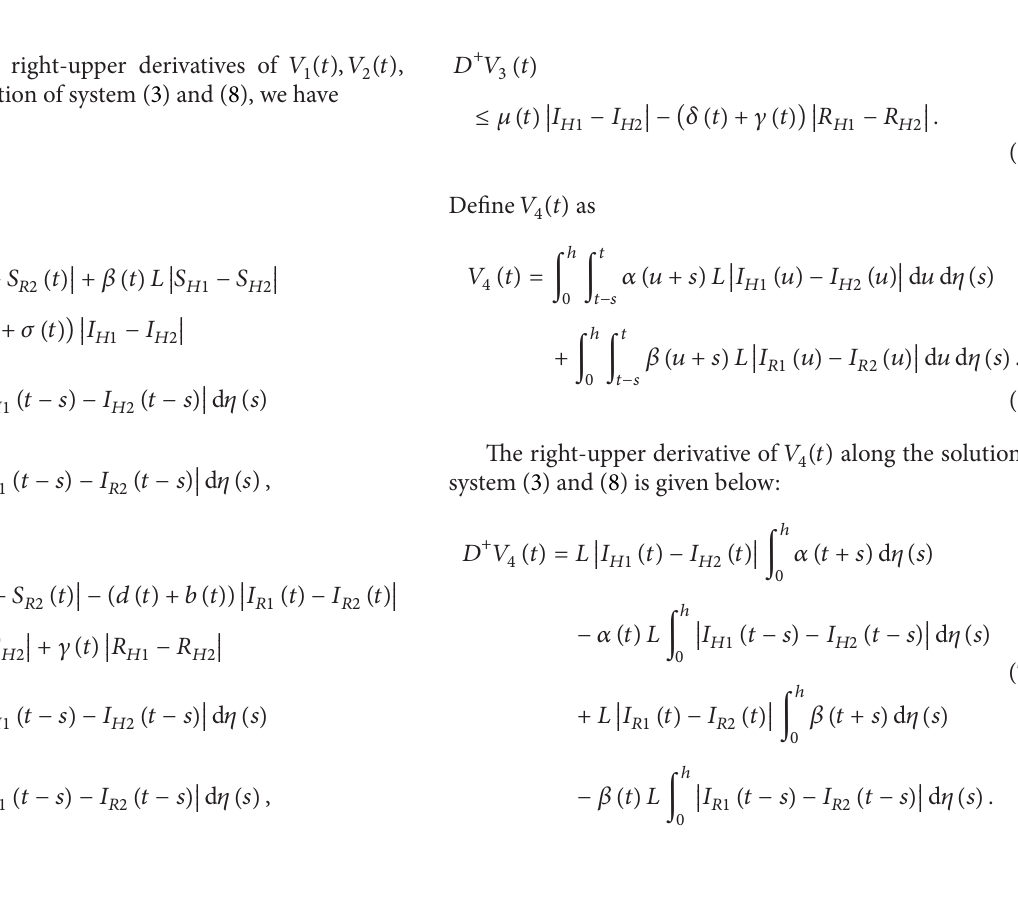
Figure 3: (a)–(e) show that the disease in system (3) with initial conditions (𝑆 𝑅 (0),𝐼 𝑅 (0), 𝑆 𝐻 (0),𝐼 𝐻 (0), 𝑅 𝐻 (0)) = (2.5, 0.15, 3.5, 0.1, 0.2) will be